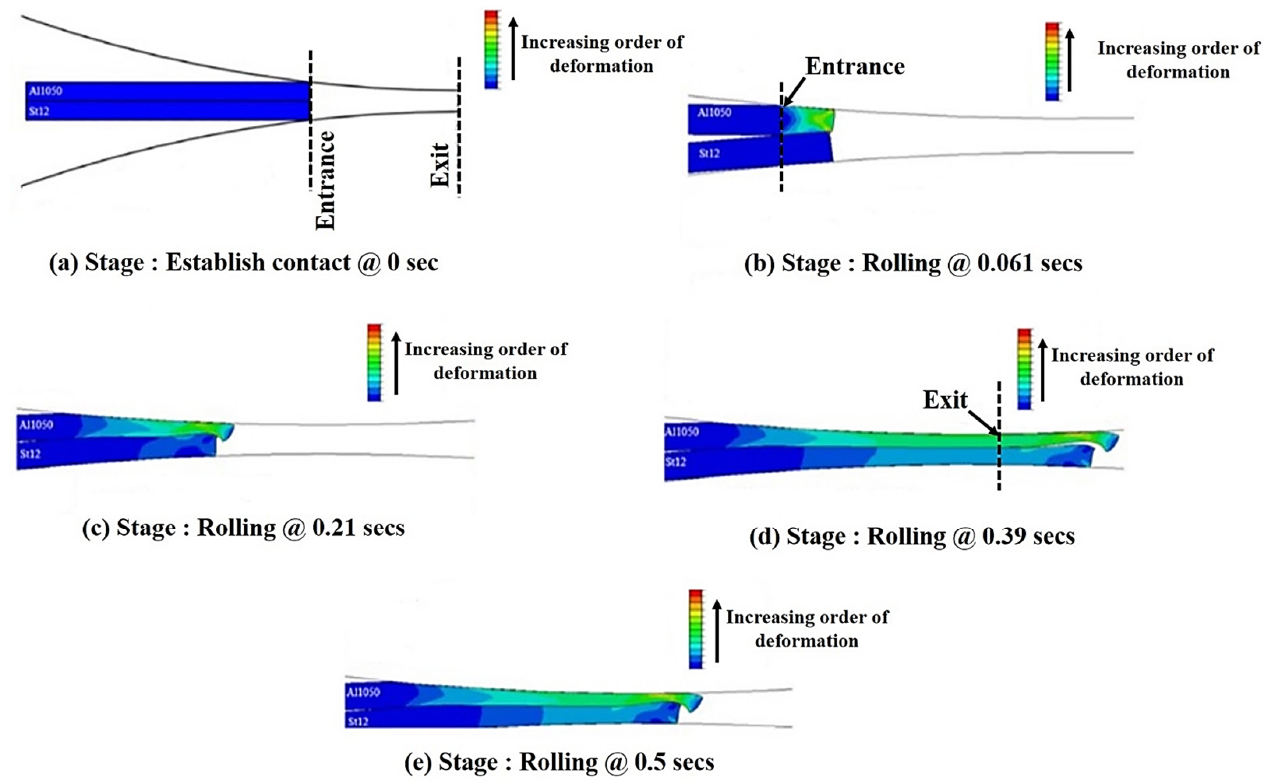
Figure 13. Equivalent plastic strain contours of Fe/Al joints obtained at different rolling times at: ( a ) 0 s, ( b ) 0.061 s, ( c ) 0.21 s, ( d ) 0.39 s, and ( e ) 0.5 s. Reproduced with permission from Ref. [96].